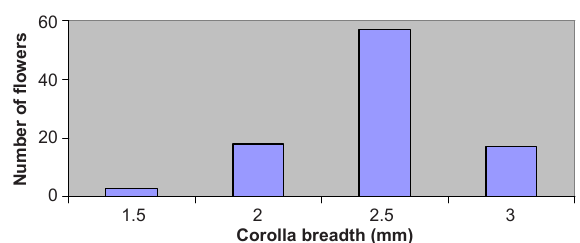
Figure 2. Frequency distribution of corolla breadth in Sarpagandha